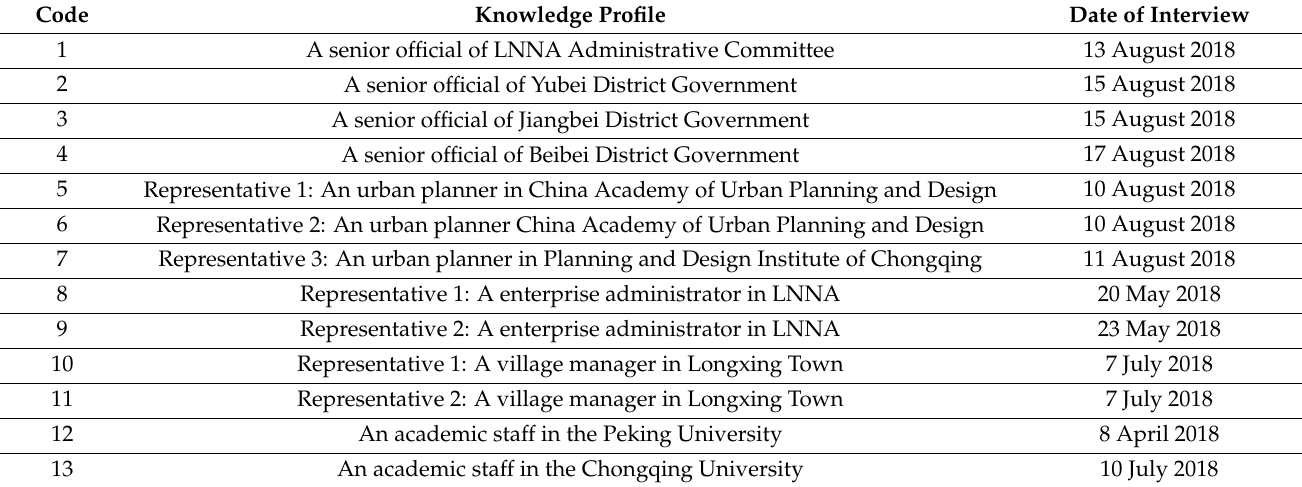
Table 2. Information for the interviewees (source: the